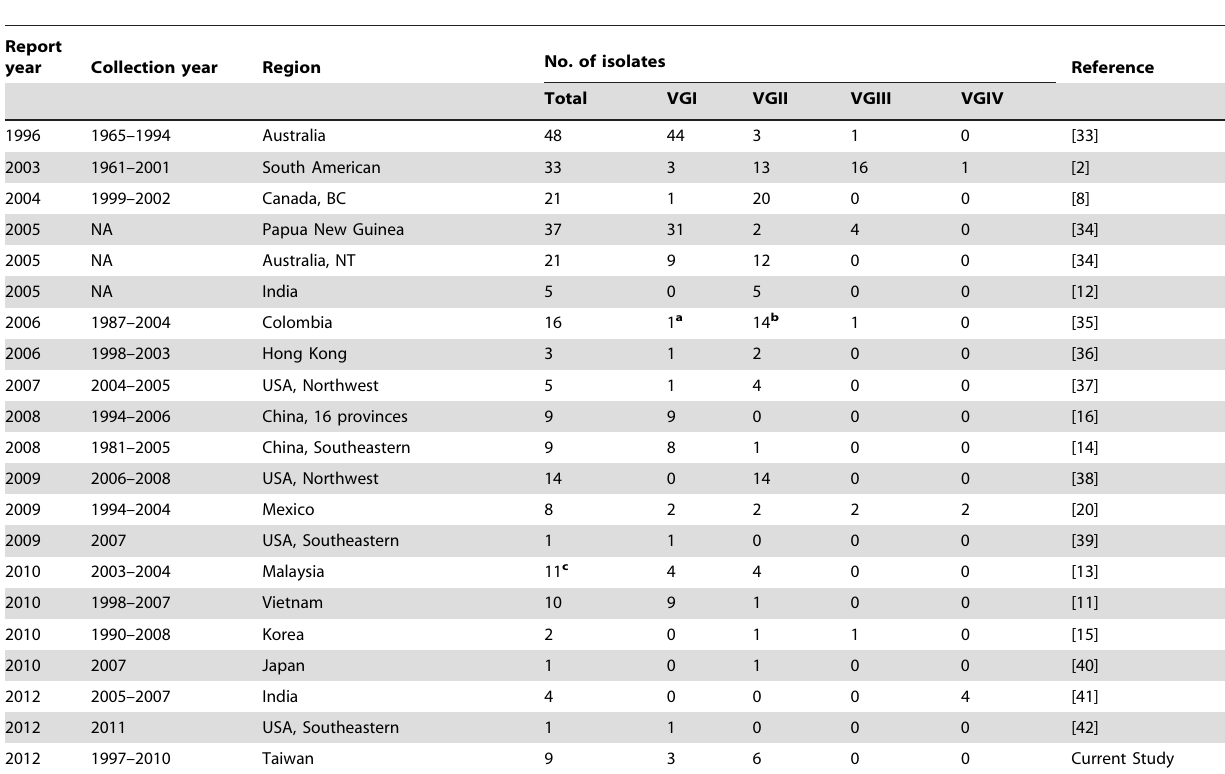
Table 5. The global distribution of clinical isolates of Cryptococcus gattii by genotype in the literature